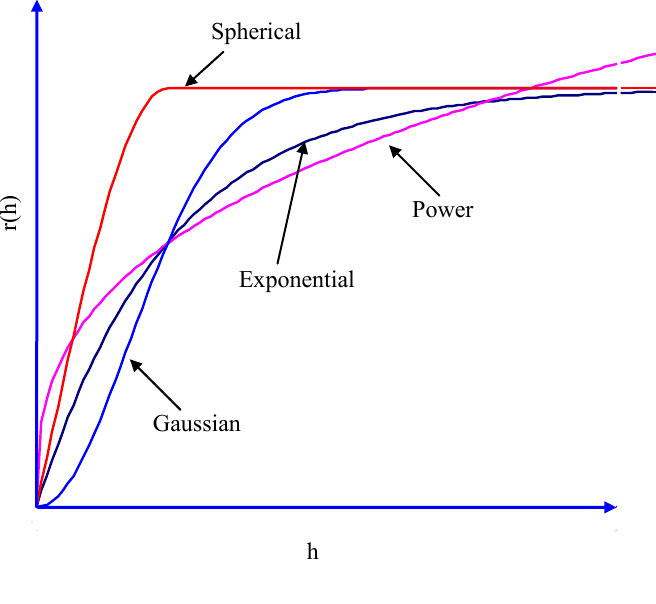
Figure 3. The theoretical